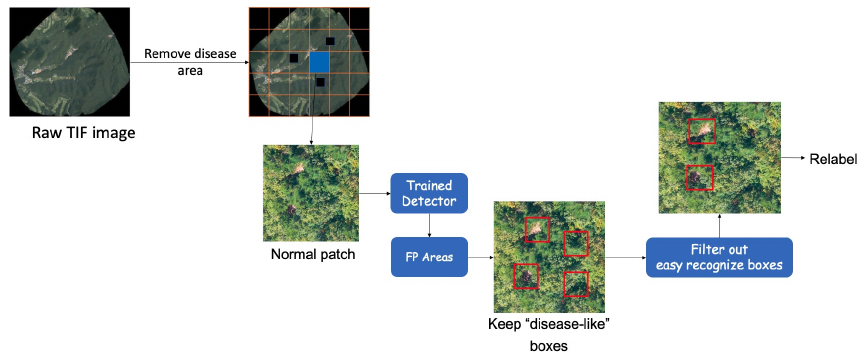
Figure 3. Extraction of “disease-like” objects.